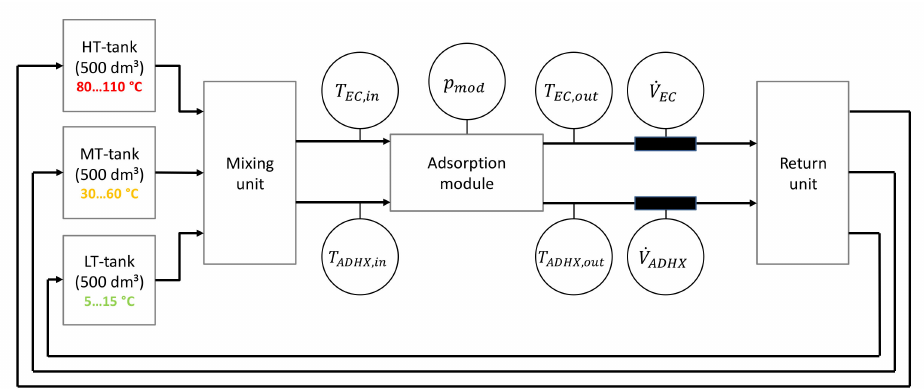
Figure 3. Schematic drawing of the test rig at Fraunhofer ISE [30] with its three temperature level tanks (HT high temperature, MT medium temperature, LT low temperature). The four inlet and outlet temperatures are measured in closest proximity to the adsorption module to avoid a bias due to the thermal capacity of the HTF between adsorption module and temperature sensor. The large volume of the tanks (500 dm 3 each) helps to achieve sharp temperature profiles.